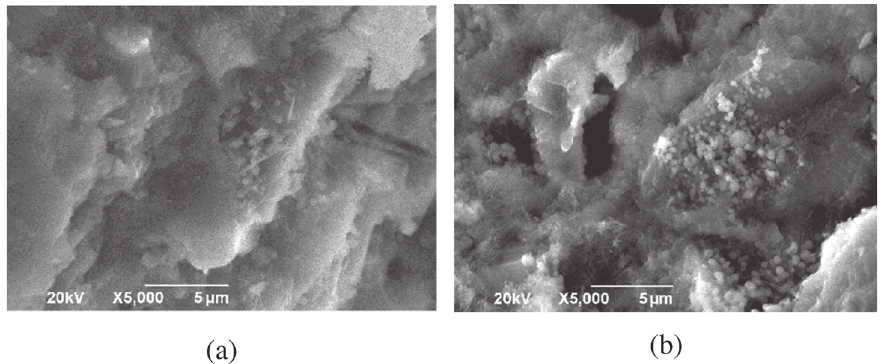
Figure 5: Microstructure of cement near the interface. (a) 20th day and (b) 40th day.